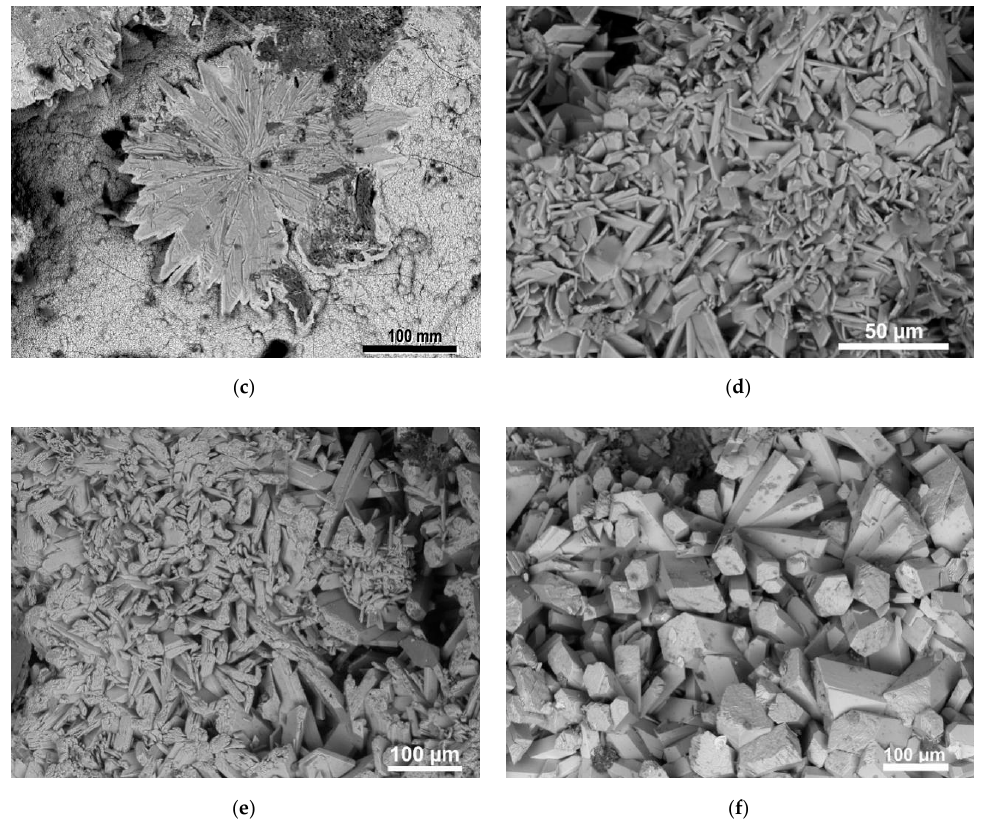
Figure 3. Secondary electron images of crystal aggregates of the erythrite–köttigite solid solution from Miedzianka: ( a ) radial platy crystal aggregates of erythrite with features indicative of autoepitaxial growth (upper and lower right); ( b ) polycentric radial aggregates of erythrite; ( c ) flat radial aggregate of erythrite (Co ≫ Zn) on the chrysocolla crust; ( d ) aggregates of Zn-rich erythrite; ( e ) aggregate of thick platy crystals of Co-rich köttigite; ( f ) prismatic crystals of köttigite.